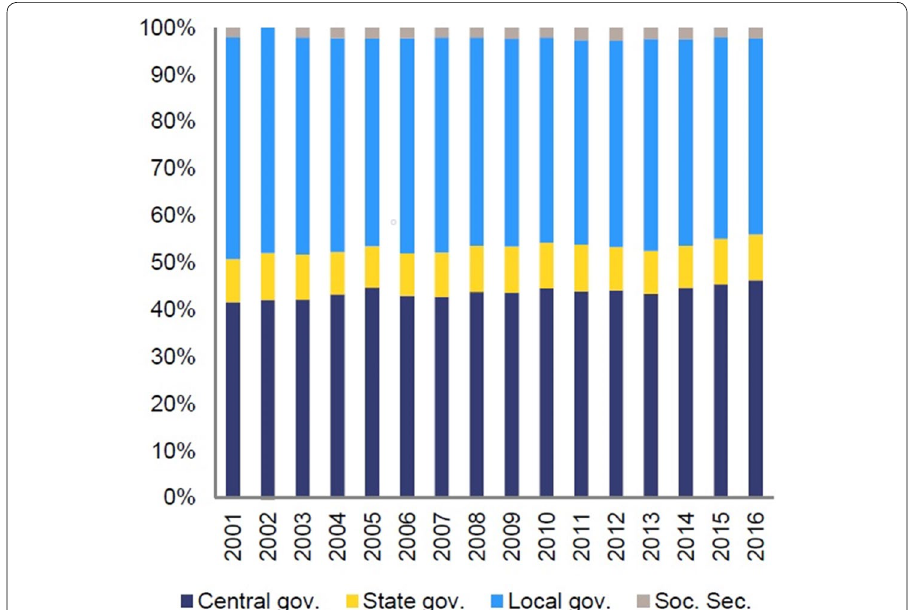
Fig. 4 Revenue distribution structure at central, state and local level Source: European Commission